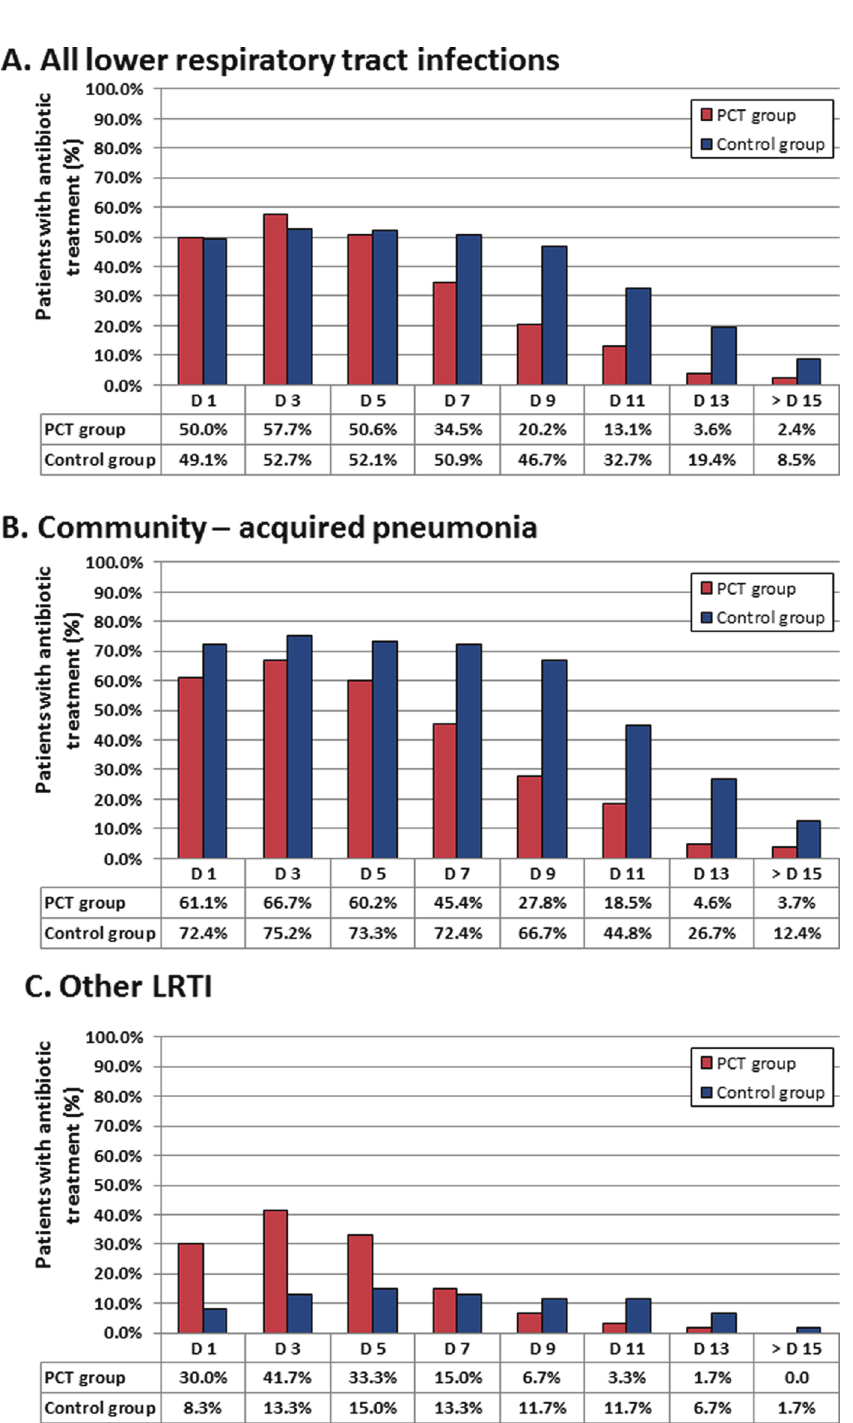
Figure 2. Antibiotic prescribing rate. Antibiotic treatment by day since randomization for all children and adolescents with lower respiratory tract infections (LRTI) and for pre-specified subgroups according to PCT guidance and control. (A) All lower respiratory tract infections; (B) Community-acquired pneumonia (CAP); (C) Bronchitis and Bronchiolitis (non-CAP LRTI).